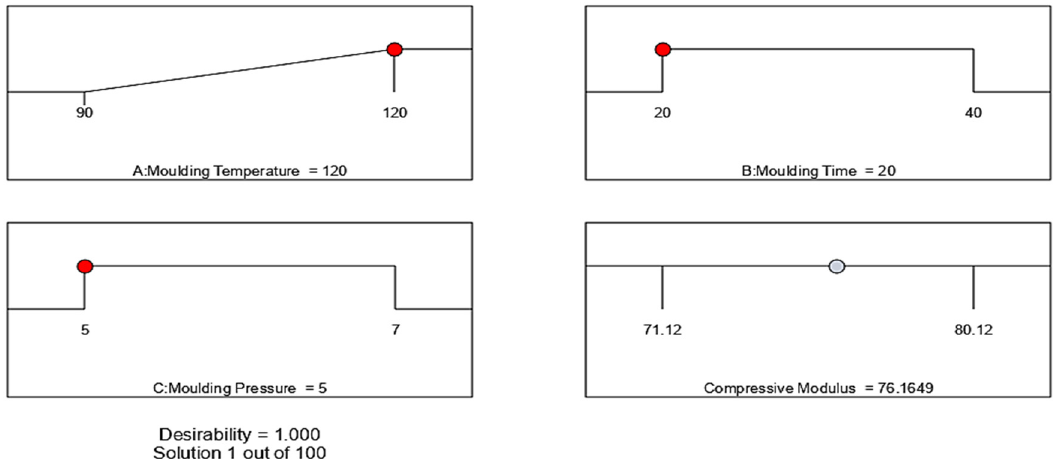
Figure 17: Ramp function graph for compression